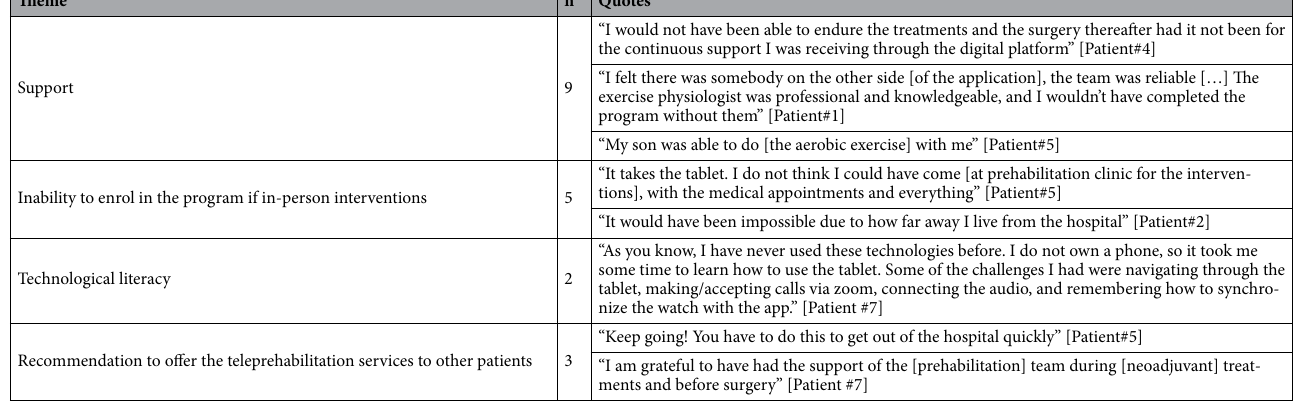
Table 5. Quotes from patients.